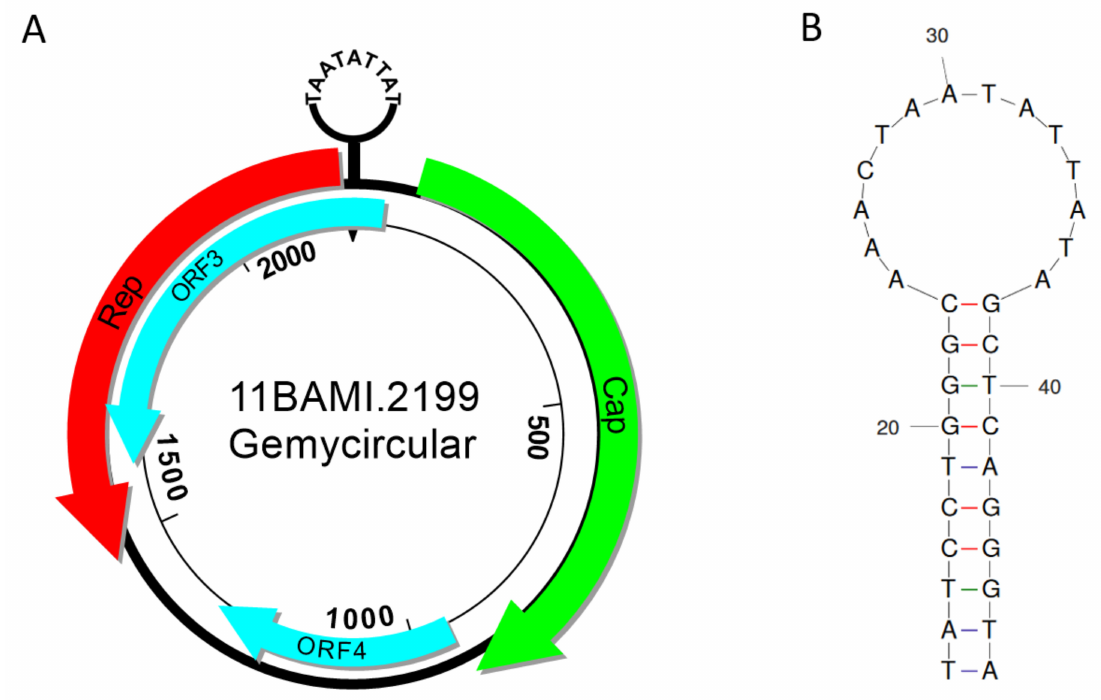
Figure 5. ( A ) Schematic map of the gemycircularvirus 11BAMI.2199. The in silico generated genes encoding Rep and Cap are shown as red and green arrows, respectively. Further putative ORFs are shown as light blue arrows. The nonanucleotide motif (TAATATTAT) within the potential stem-loop structure at position 1 is depicted at the top. ( B ) Enlarged view of the stem-loop structure between rep and cap as a potential origin of replication as calculated by the ProbKnot server at the University of Rochester. The nucleic acid type was set to DNA (http://rna.urmc.rochester.edu/RNAstructureWeb/Servers/ ProbKnot/ProbKnot.html; accessed on 17 March